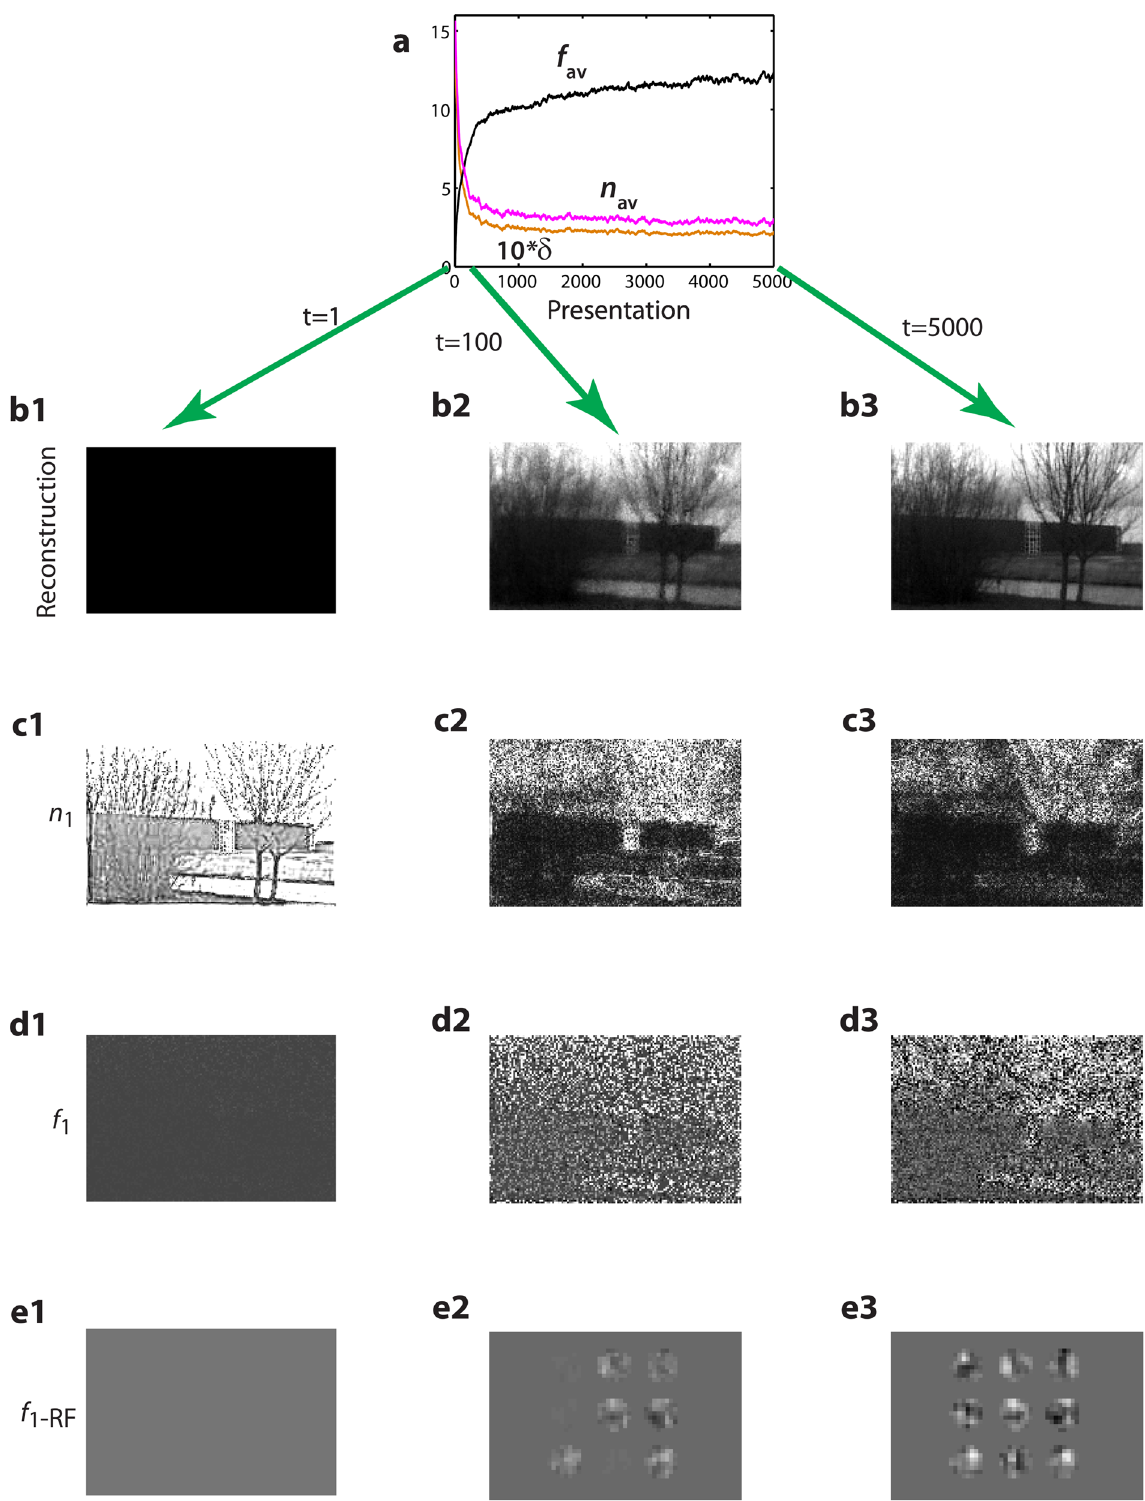
Fig 3. Local recurrent connectivity emerging from unsupervised learning improves reconstruction quality. a Evolution of reconstruction error ( δ , golden, averaged across 50 consecutive presentations) during 5000 random presentations from a set of 1000 training images. Average activity of level-1 novelty neurons ( n av , magenta) mirrors decrease in δ . Initial sharp decrease in n 1 activity is explained by average activity increase of level-1 familiarity